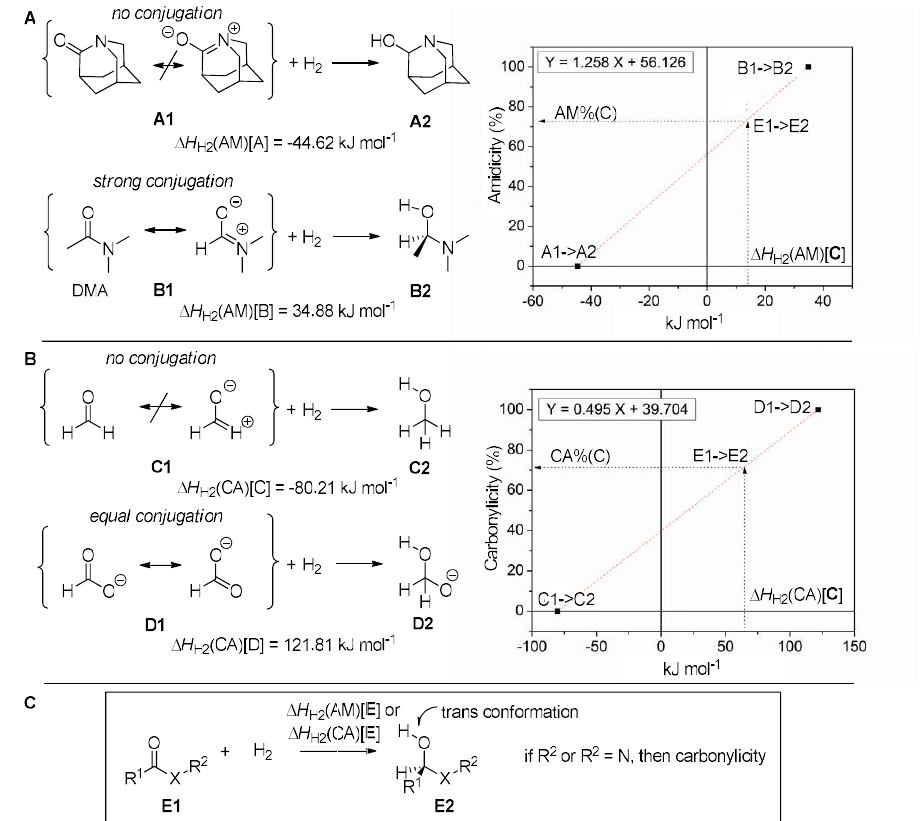
Figure 3. The definition of the amidicity ( A ) and carbonylicity ( B ) percentage based on the